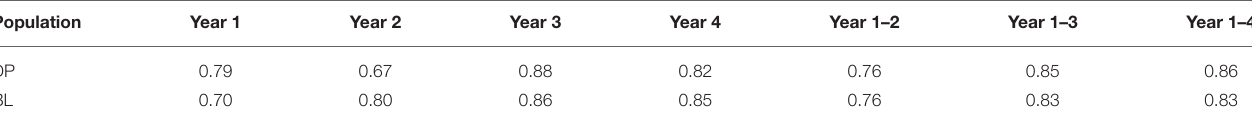
TABLE 3 | Phenotypic correlations between IT and disease SEV.